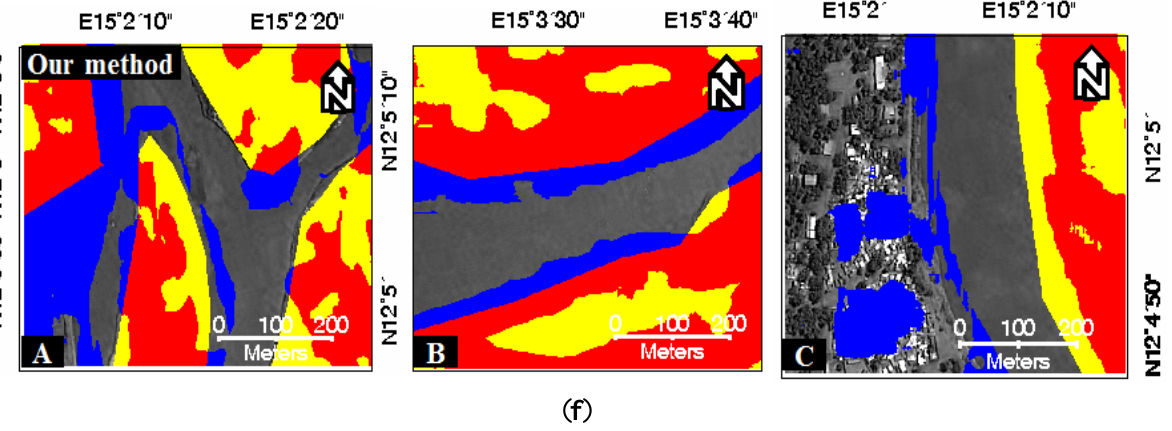
Figure 6. Sub-images extracted from different regions of Figure 5: ( a ) a location map of each sub-image; ( b ) MAD result; ( c ) CVA result; ( d ) SVM result; ( e ) MFI result; ( f ) result of the proposed method. The red color represents the correctly extracted flood pixels, the blue color shows the commission error, and the yellow color shows the omission error. Table 2. Accuracy assessment of the tested change detection methods: (F) Flood, (NF)